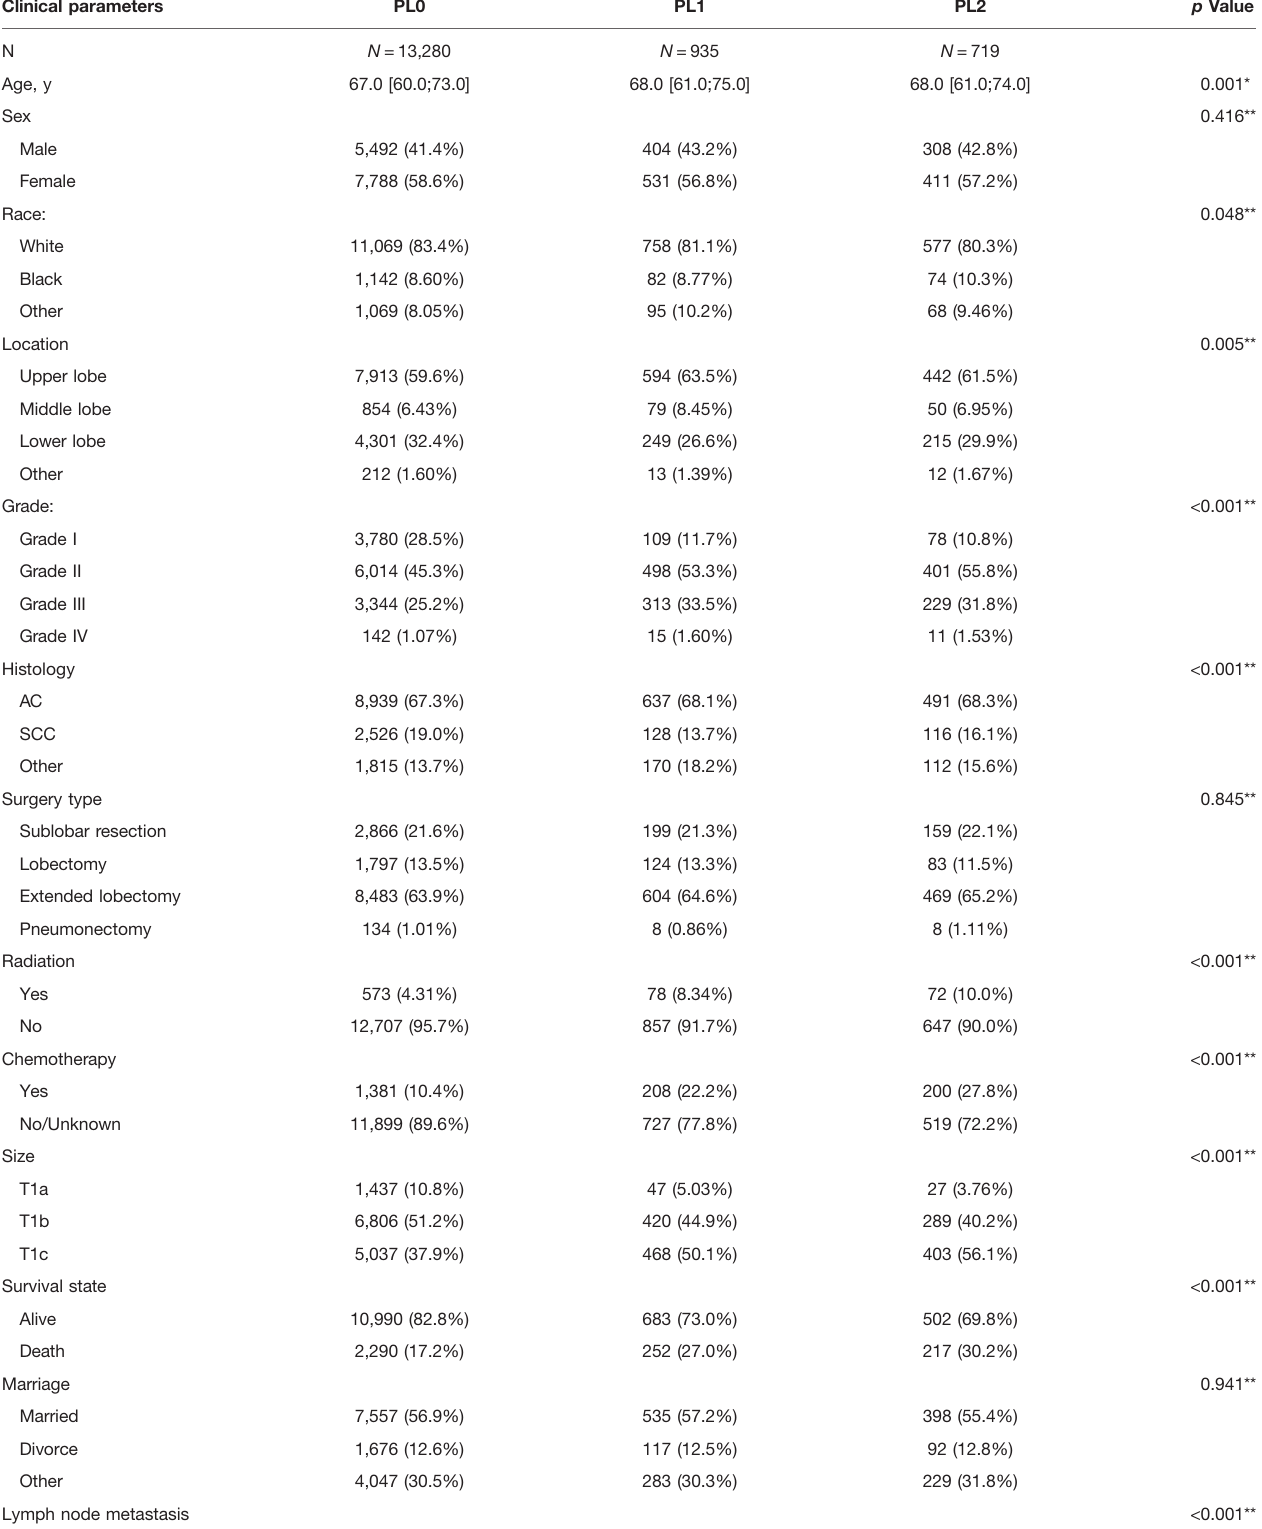
TABLE 1 | Clinicopathological characters of NSCLC patients with the different subdivision levels of VPI. Clinical